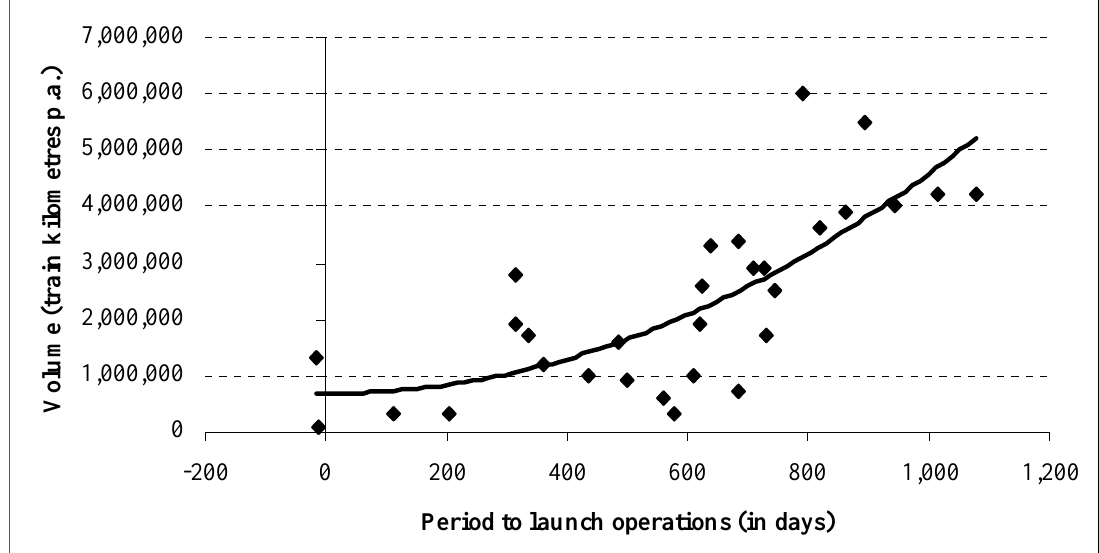
Figure 5. Best matched trend plot for volume and period to launch